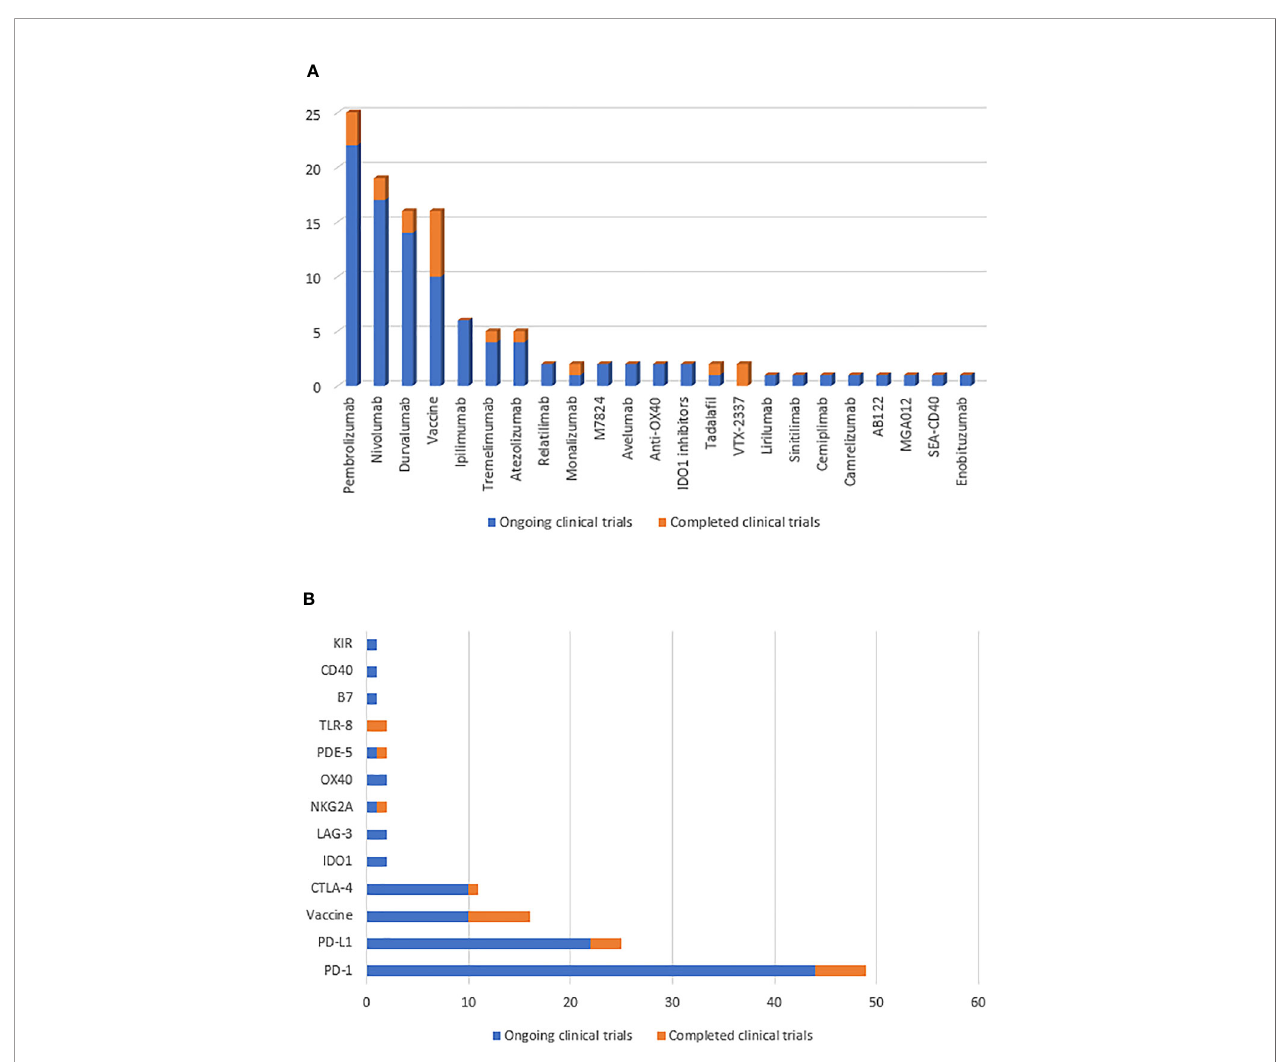
FIGURE 3 | (A) Summarize the number of clinical trials of immunotherapy drugs for HNSCC patients. (B) Summarize the number of clinical trials of immunotherapy targets for HNSCC patients. Yellow indicates completed clinical trials and blue indicates ongoing clinical